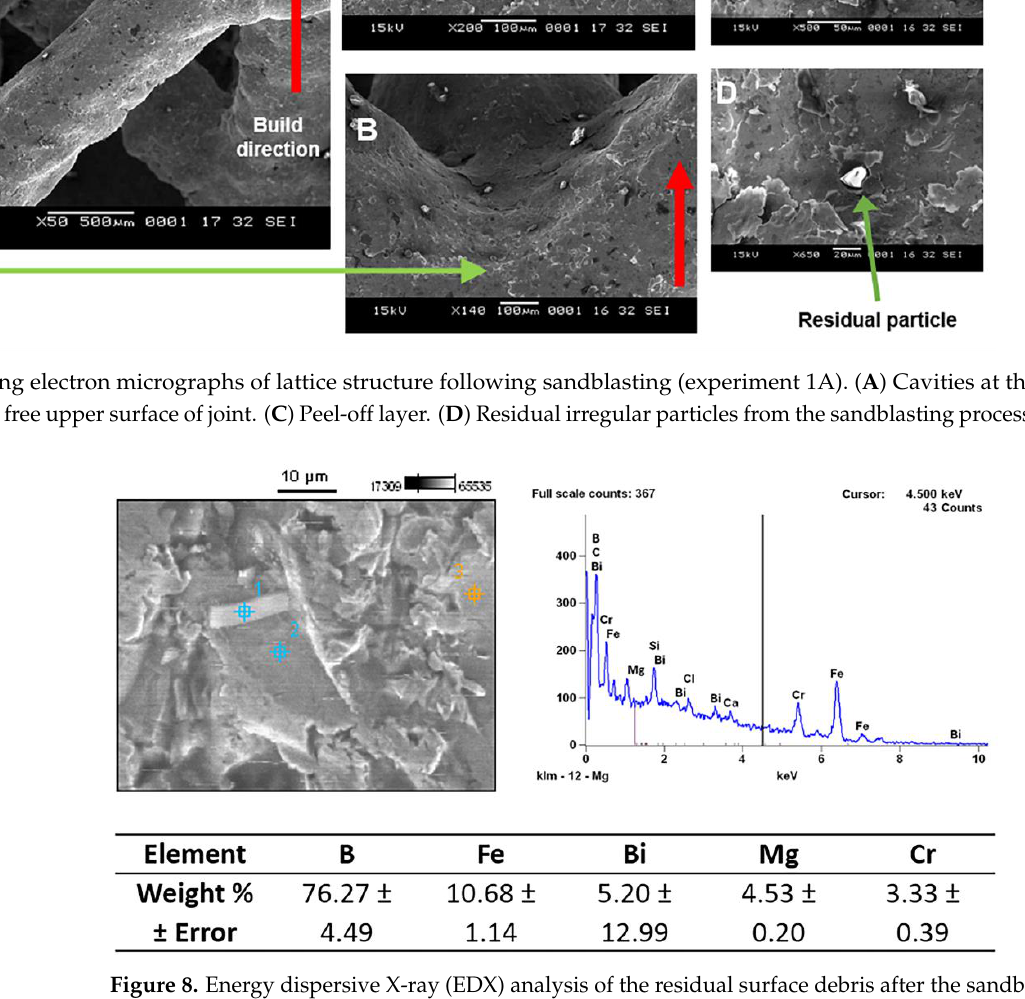
Figure 8. Energy dispersive X-ray (EDX) analysis of the residual surface debris after the sandblasting process. Three different regions were analyzed ( 1 , 2 and 3 ), and the energy dispersion spectrum and corresponding average weight percentages of the constitutive elements from the EDX analysis are shown.